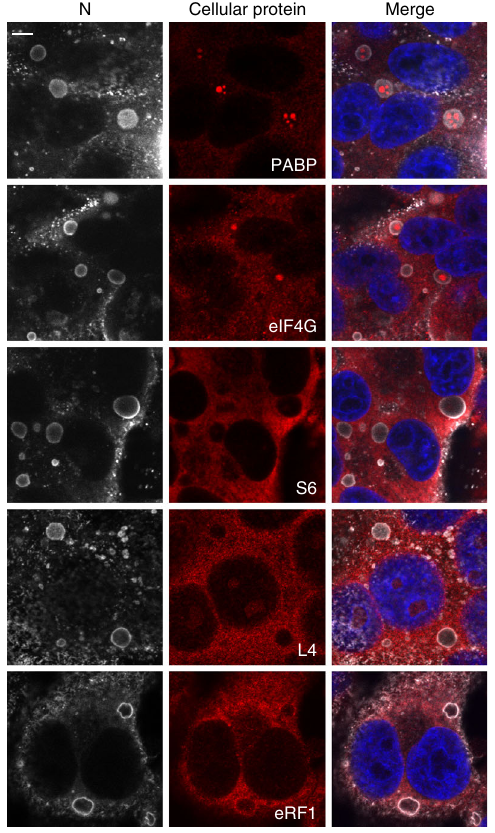
Fig. 3 Cellular proteins required for translation do not colocalyze with IBs or IBAGs. HEp-2 cells were infected with RSV. At 24 h p.i., cells were immunostained either with an anti-PABP (mRNA interacting protein), an anti-eIF4G (translation initiation factor), an anti-S6 (small ribosomal subunit protein), an anti-L4 (large ribosomal subunit protein) or an anti-eRF1 (translation termination factor) as indicated on the pictures (cellular protein in red ). Cells were also stained with an anti-N antibody ( gray ) to detect IBs and with Hoechst 33258 (merge). Representative images from three to four independent experiments are shown. Images were taken under a confocal microscope. Scale bar 5 µ m